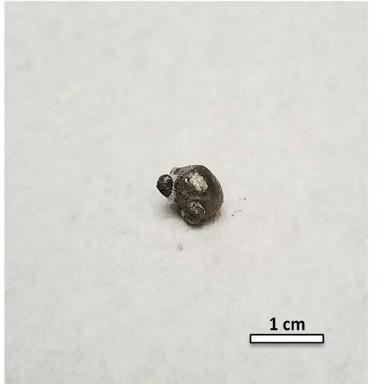
The U metal product that was contained within the slag-like coating.